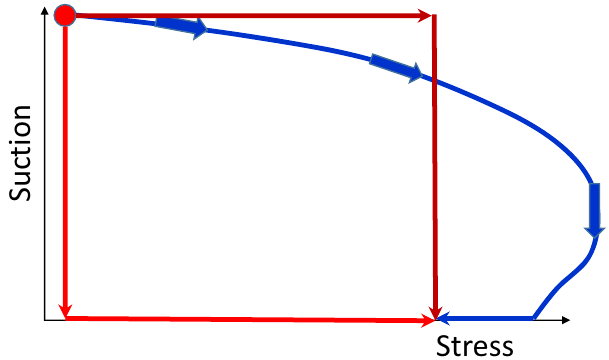
Fig. 5. Suggested suction-stress paths to check stress path dependency from an unsaturated to a saturated state. Stress may be vertical total stress (in oedometer tests) or mean total stress (in isotropic